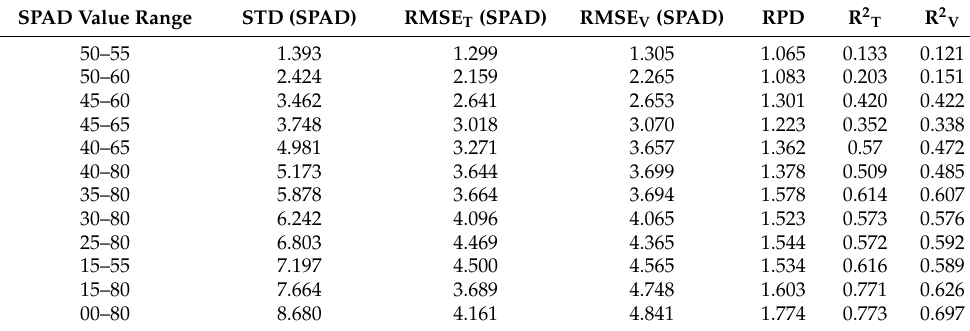
Table 7. The estimation results of different SPAD value ranges.